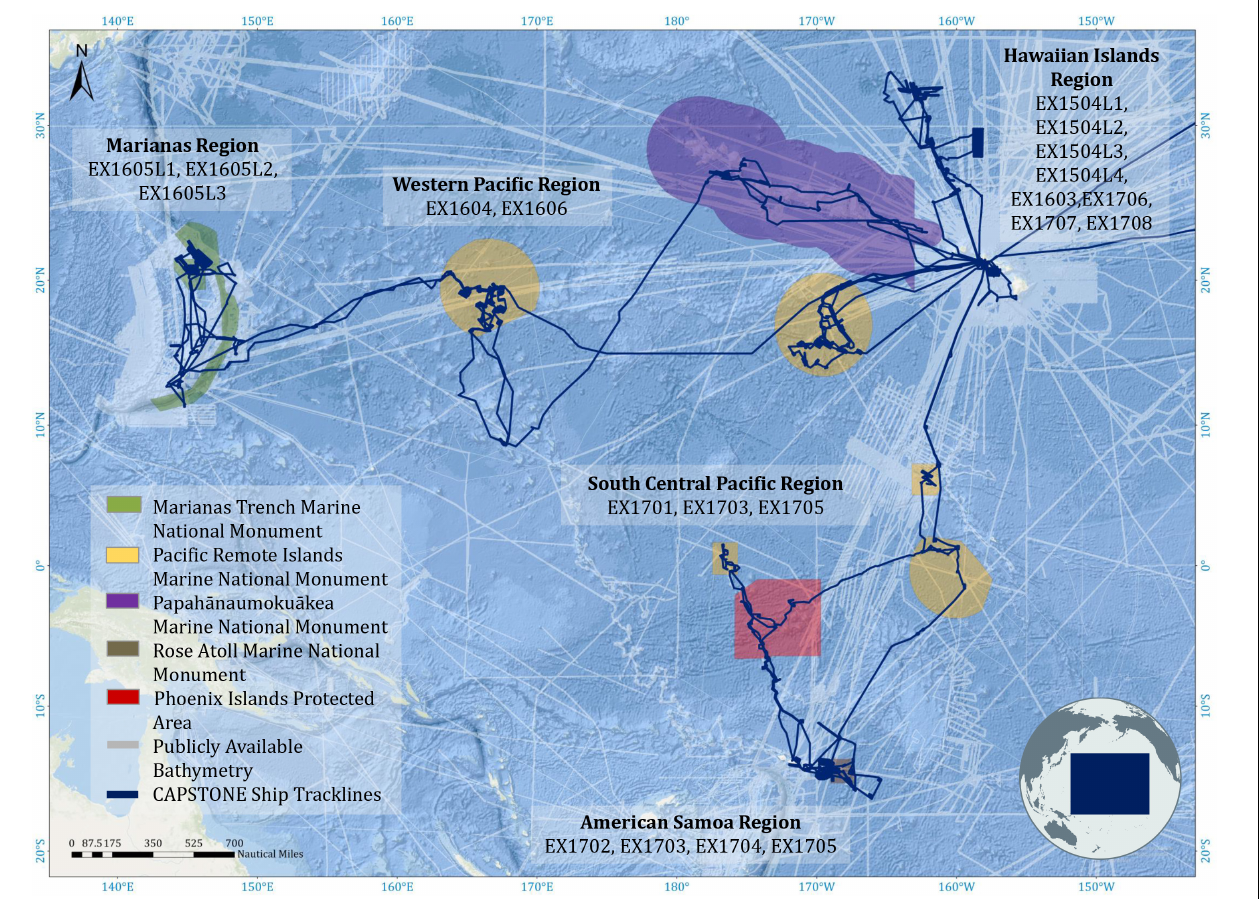
FIGURE 1 | Multibeam EM302 operations conducted by NOAA Ship Okeanos Explorer (dark blue ship track lines) during CAPSTONE 2015–2017. Existing bathymetry background layer was obtained from National Centers for Environmental Information (NCEI), made available through a request to NCEI staff to provide multibeam footprint of data held at